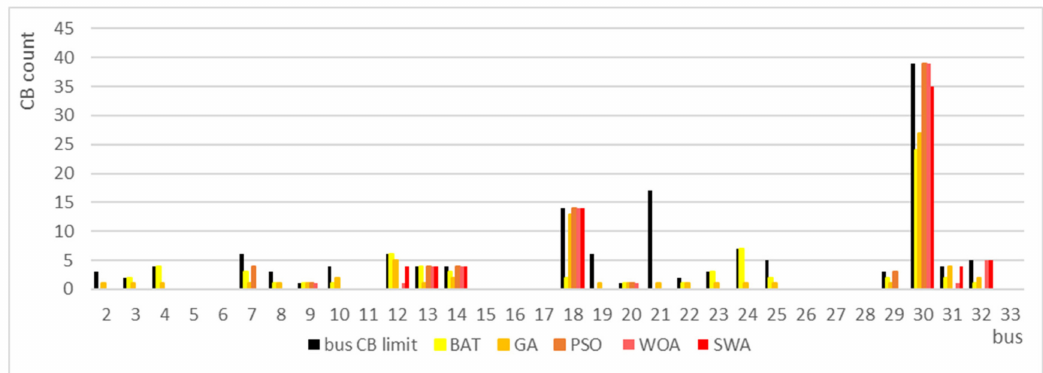
Figure 14. The number of CBs allocated in the buses of the IEEE 33-bus system by each algorithm.